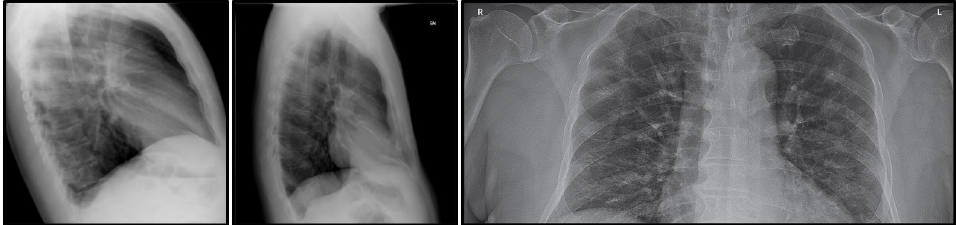
Figure 1. Samples of removed X-ray images. The first two samples are removed because they were captured from the side view, while the third sample is removed because of the incomplete information on the frontal chest X-ray